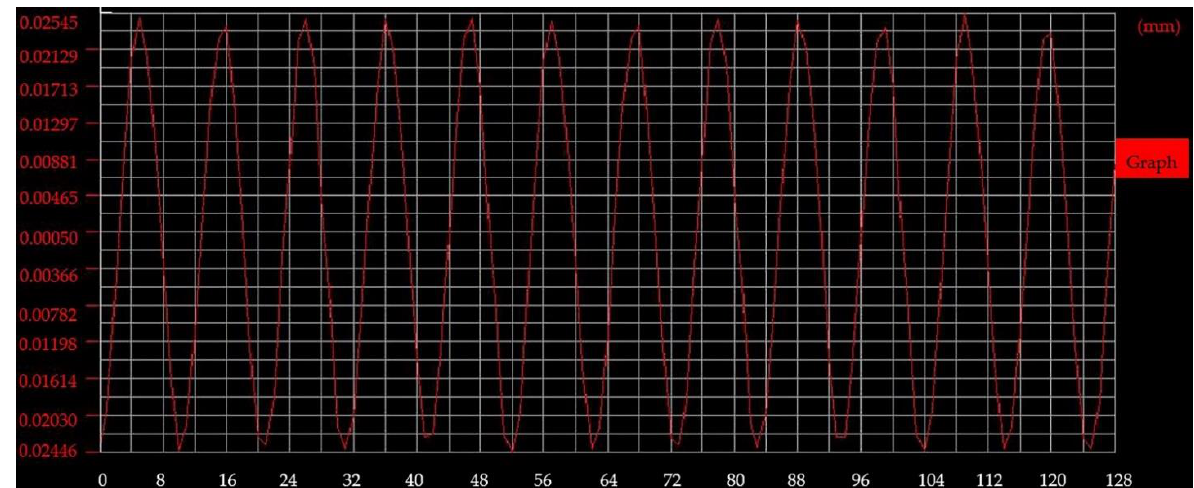
Figure 15. Data recorded by the laser sensor.